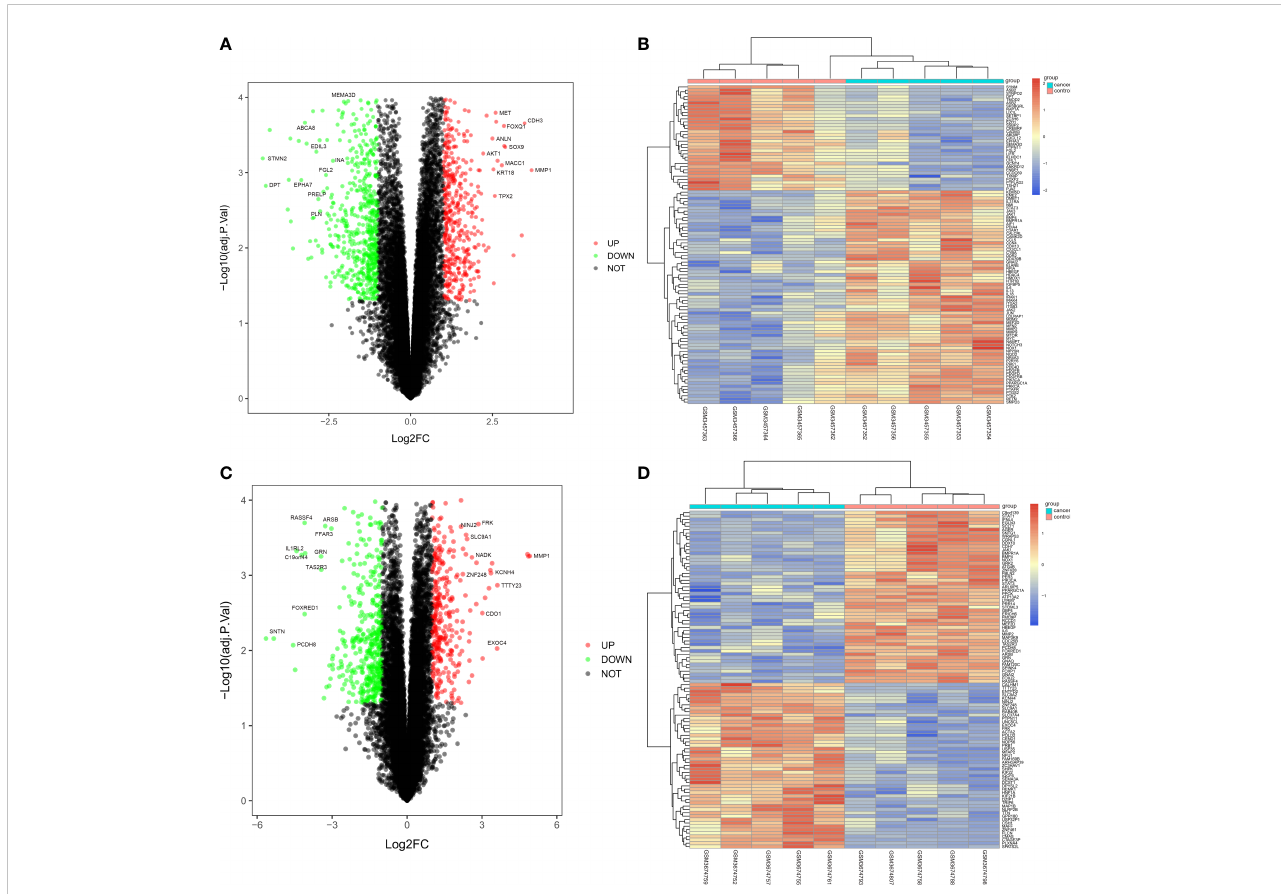
FIGURE 1 Screening of DEGs. (A, B) Volcano plot and heatmap of DEGs in GSE122183; (C, D) Volcano plot and heatmap of DEGs in GSE128435. DEGs, differentially expressed